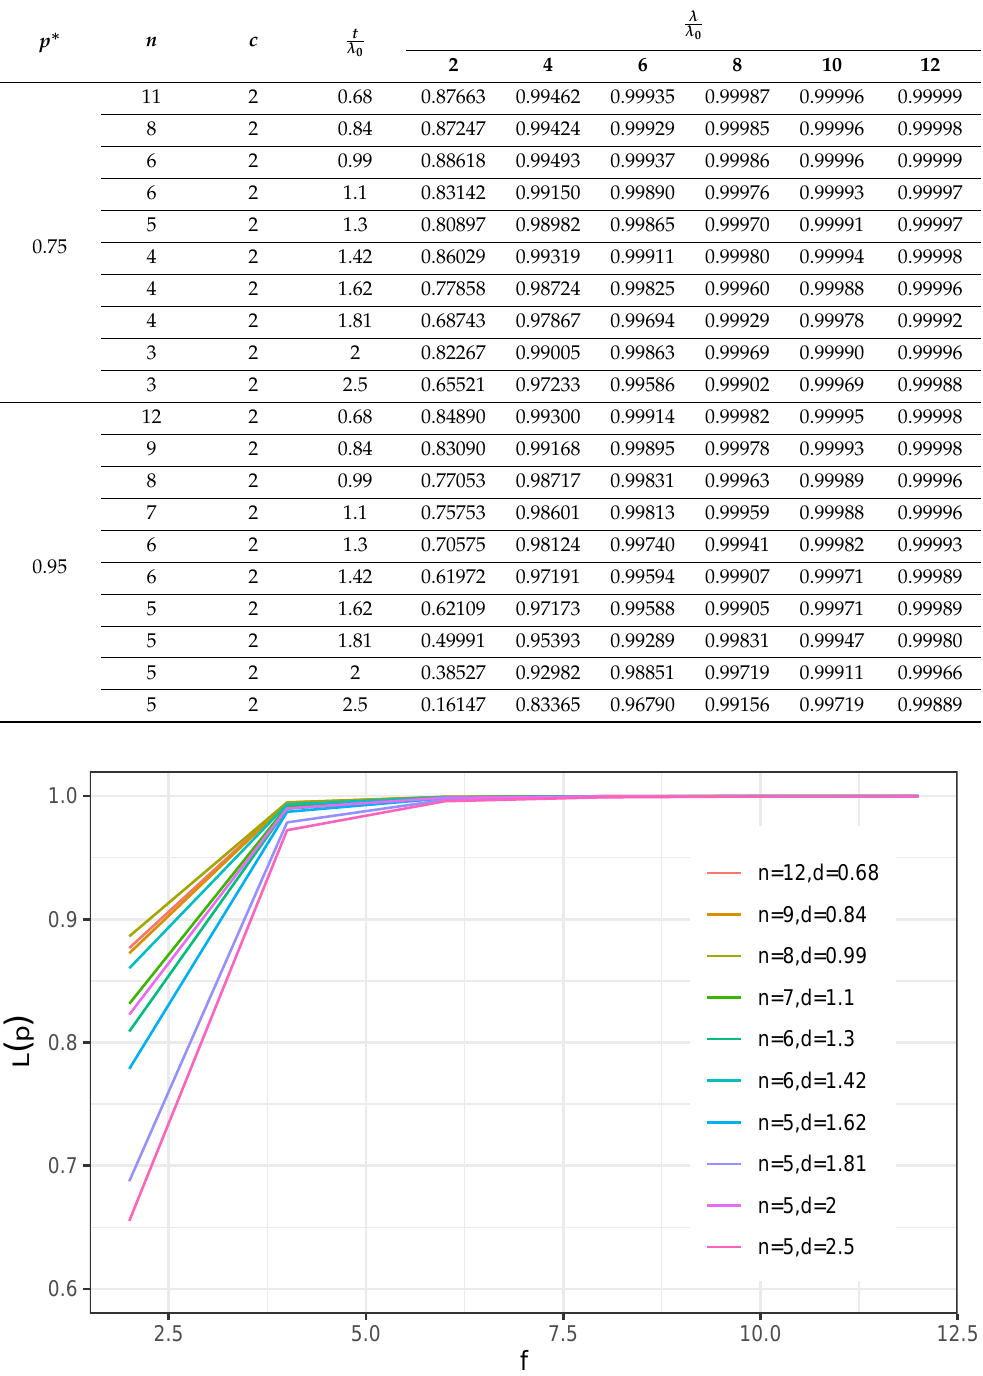
(cid:0) (cid:1) n , c , t λ